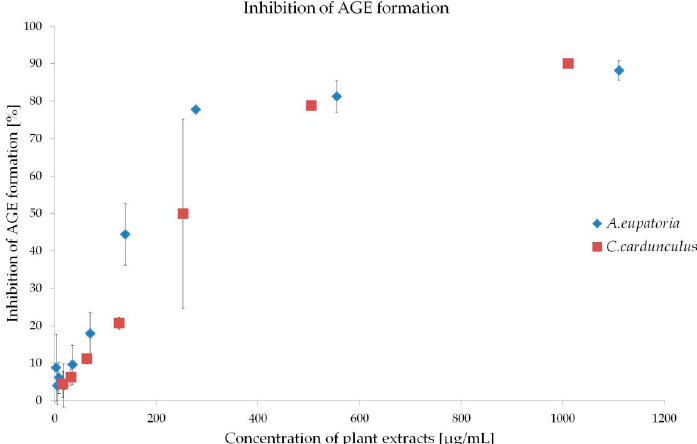
Figure 2. Inhibition of AGE (advanced glycation end-products) formation by A. eupatoria and C. cardunculus water extracts in the BSA-GLC (bovine serum albumin-glucose) model. Data are shown